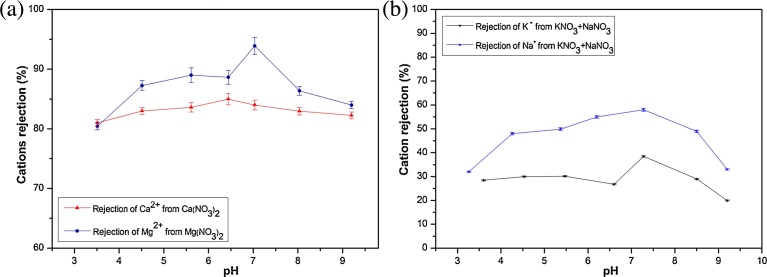
Influence of feed pH on cation rejections (%) in binary solutions Ca(NO3)2, Mg(NO3)2 solutions (a) and ternary solutions (NaNO3 + KNO3) (b) (at fixed ΔP = 6 bar and Ci = 50 mg(NO3−)/L).